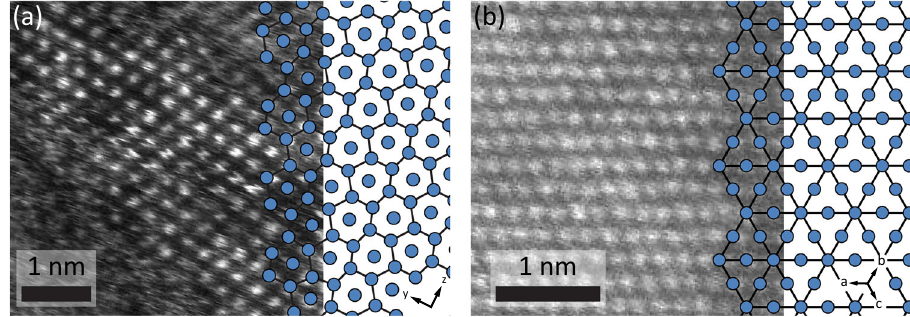
Fig. 2 Crystal structures of Cf 2 O 3 and BkO 2 . a Cf 2 O 3 viewed along the [100] lattice vector and partly overlaid schematic showing Cf columns. b BkO 2 viewed along the [111] lattice vector with Bk atoms shown in blue in the partly overlaid schematic. Please note that O atoms are not visible in the HAADF- STEM images and are therefore not shown in the schematic, either. In the schematics, atoms were connected by lines to accentuate structural